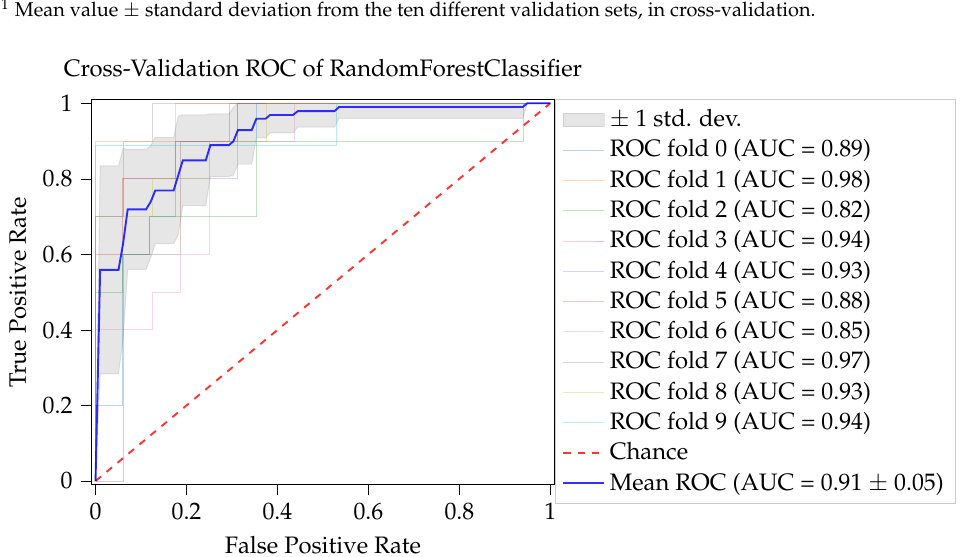
1 Mean value standard deviation from the ten different validation sets, in cross-validation. ±